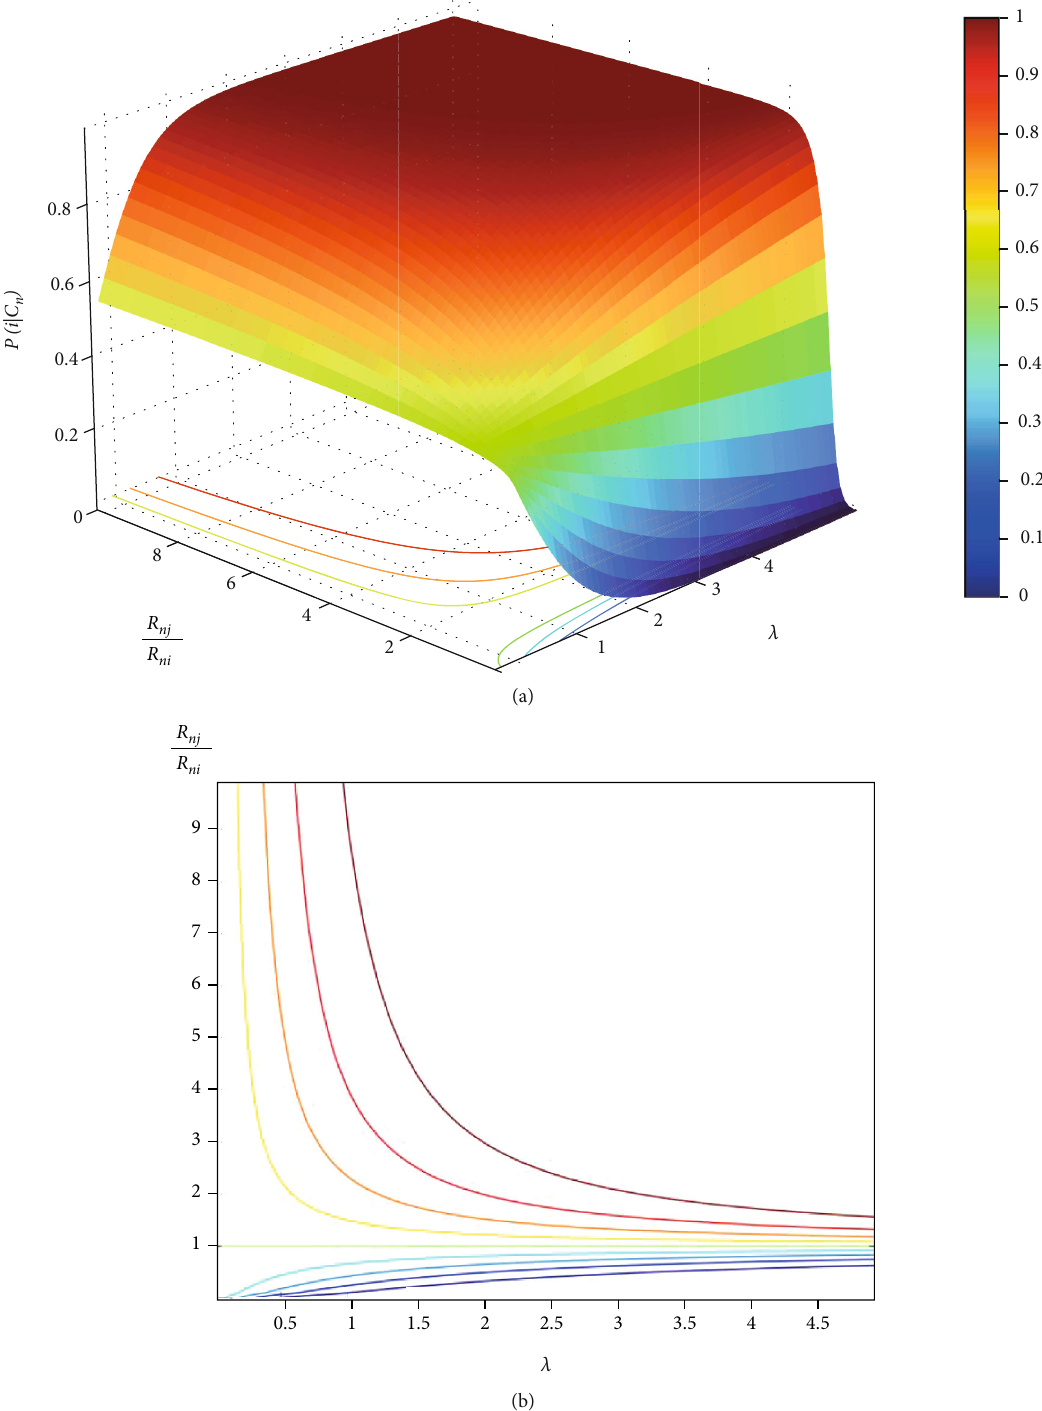
Figure 4: Relationship among the probability, shape parameter, and relative di ff erence (a) surface plot (b) contour